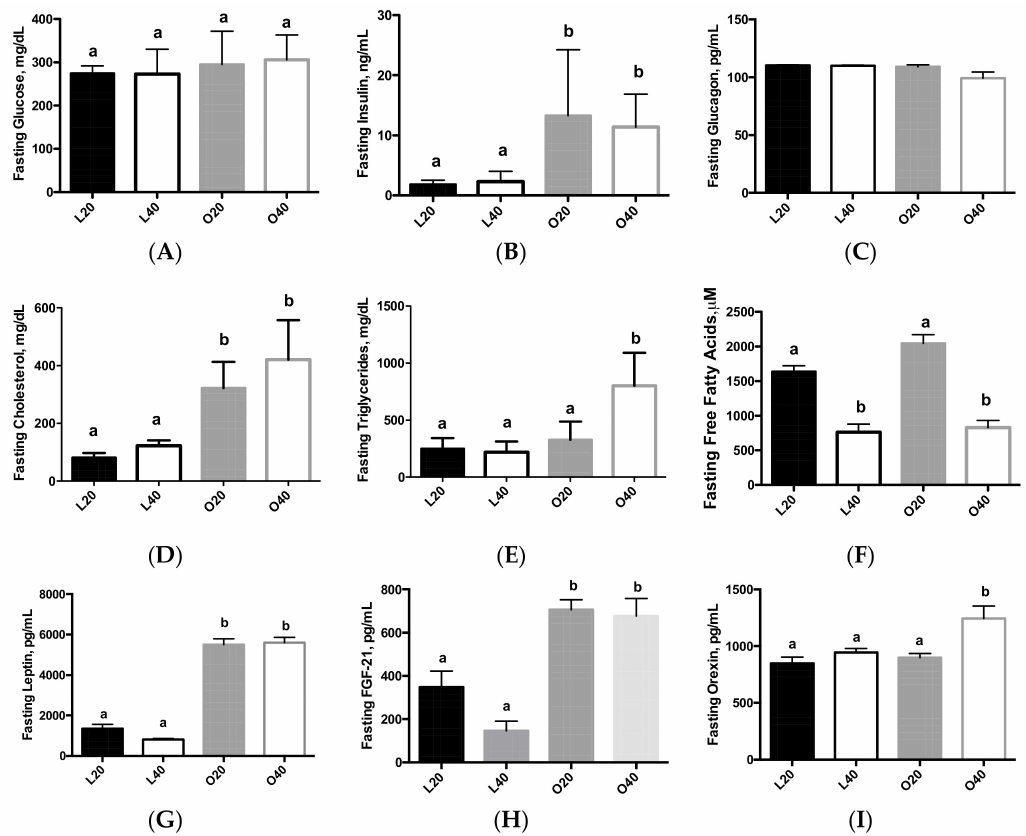
Figure 2. Biomarkers of type 2 diabetes following 12 weeks of consuming either a 20% protein or 40% protein diet in lean control (L) or obese Zucker (O) rats. ( A ) Fasting glucose; ( B ) Fasting insulin; ( C ) Fasting glucagon; ( D ) Fasting cholesterol; ( E ) Fasting triglycerides; ( F ) Fasting free fatty acids; ( G ) Fasting leptin; ( H ) Fasting FGF-21; ( I ) Fasting orexin. Values are means + SEM. Data was analyzed using one-way ANOVA. Values without a common letter differ, p < 0.05. FGF-21, fibroblast growth factor-21; L20, lean 20% protein; L40, lean 40% protein; O20, obese 20% protein; O40, obese 40%